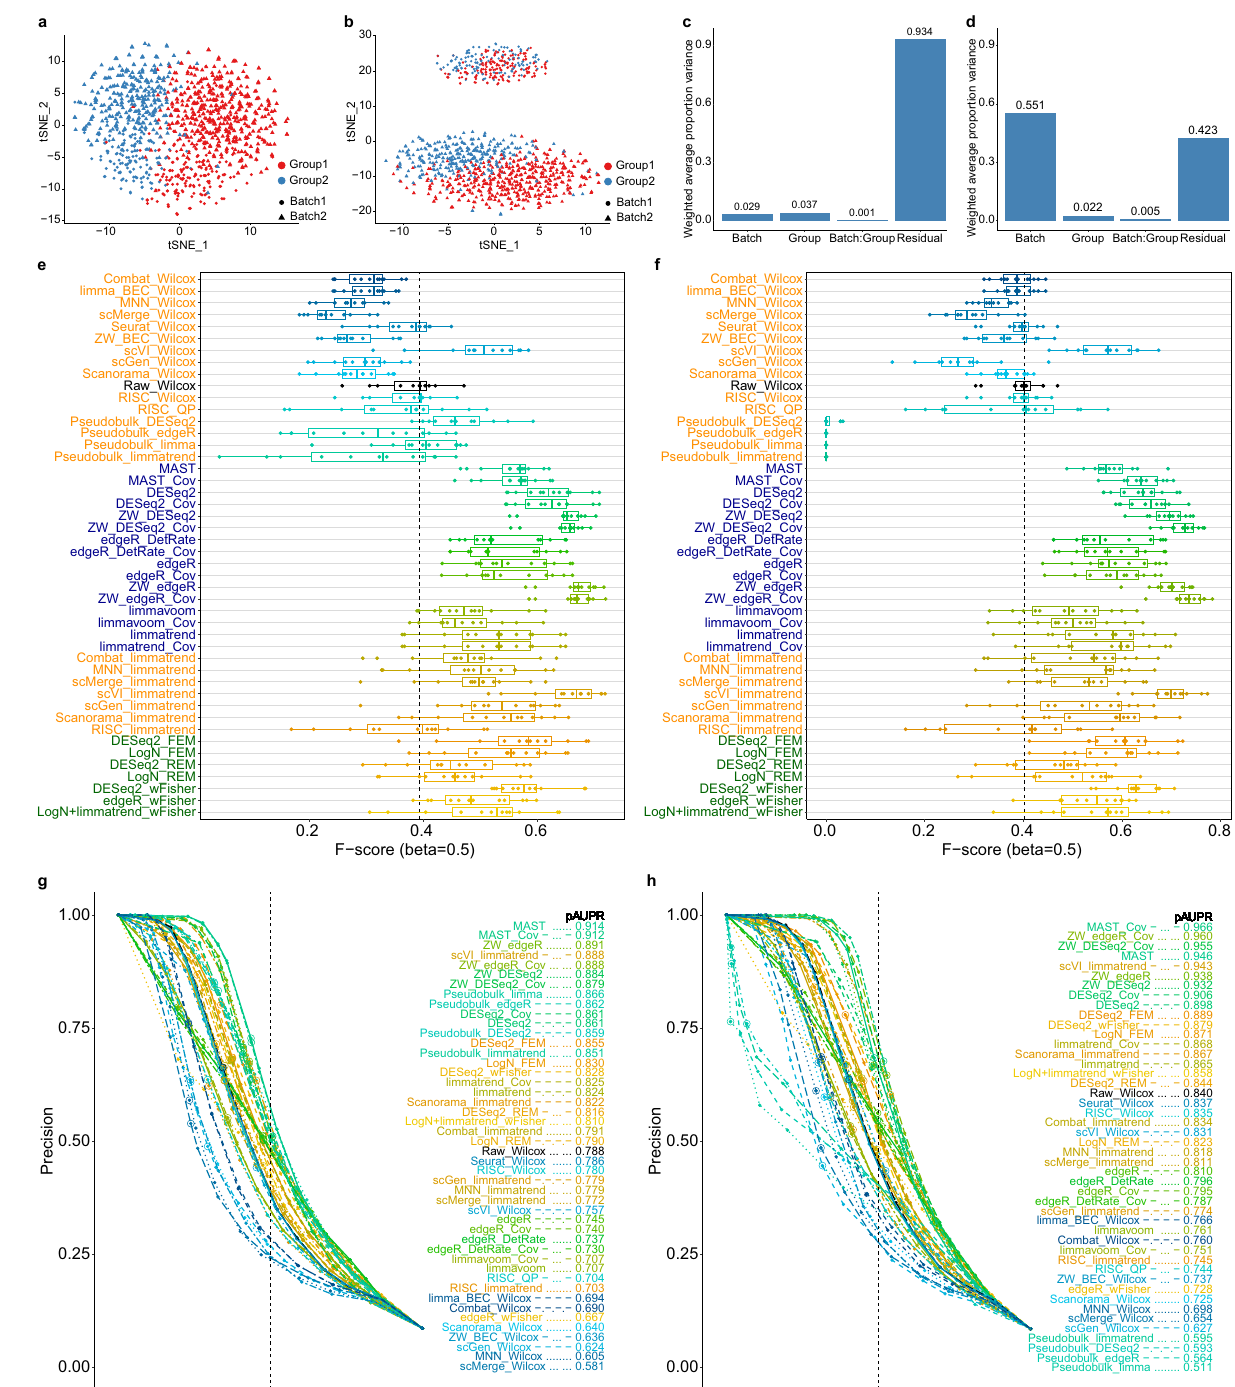
Fig.2|Model-basedsimulationresultsformoderatedepths(twobatches;zero rate>80%). Scatterplots(tSNE)oftwobatchesfor a smalland b largebatcheffects. Principal variance component analysis results representing c small and d large batch effects. F 0.5 -scores for 46 differential expression (DE) work fl ows for e small and f large batch effects. Results for six cell proportion scenarios (12 instances in total: six for upregulated genes and six for downregulated genes) are represented as boxplots; the lower, center and upper bars represent the 25th, 50th and 75th